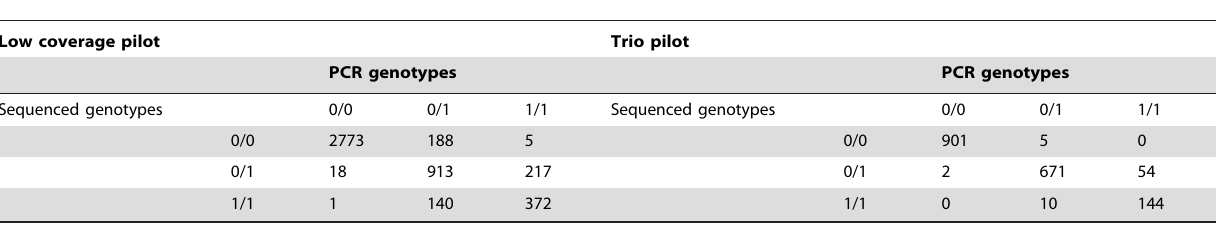
Table 3. Non-reference MEI genotype contingency